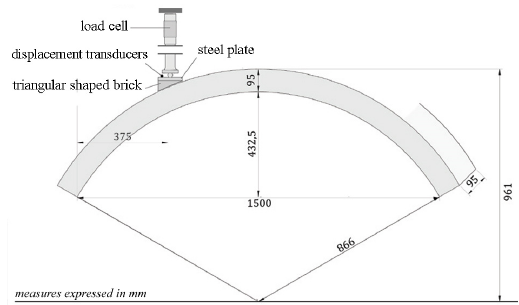
Figure 2. Scheme of the arch model test.